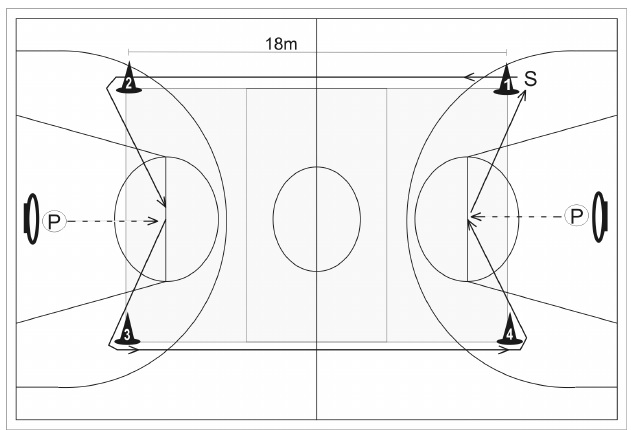
Figure 1. The dynamic 60-second free throw shooting test (S1P60). Legend. P = passer, S = shooter/testee.